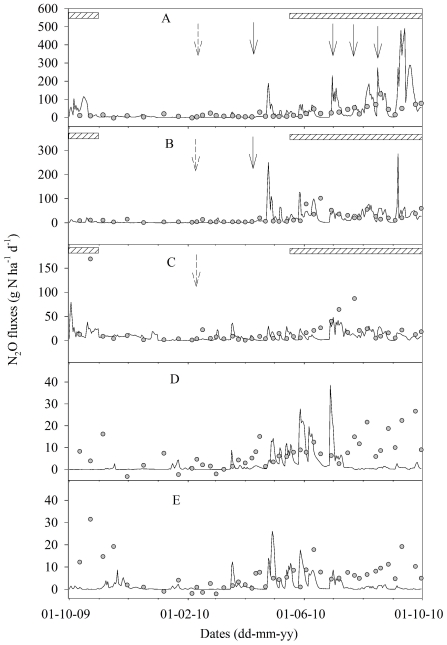
Daily N2O fluxes.Simulated (—) and measured (•) N2O fluxes for (A) GG+FN, (B) GWC+FN, (C) GWC-FN, (D) G-B and (E) WC-B. Each value is the mean of fluxes from the three paddocks or plots. Dashed or solid arrows indicate when slurry or FN was applied, respectively. The vertical edges of the shaded boxes denote the start and end of grazing period.